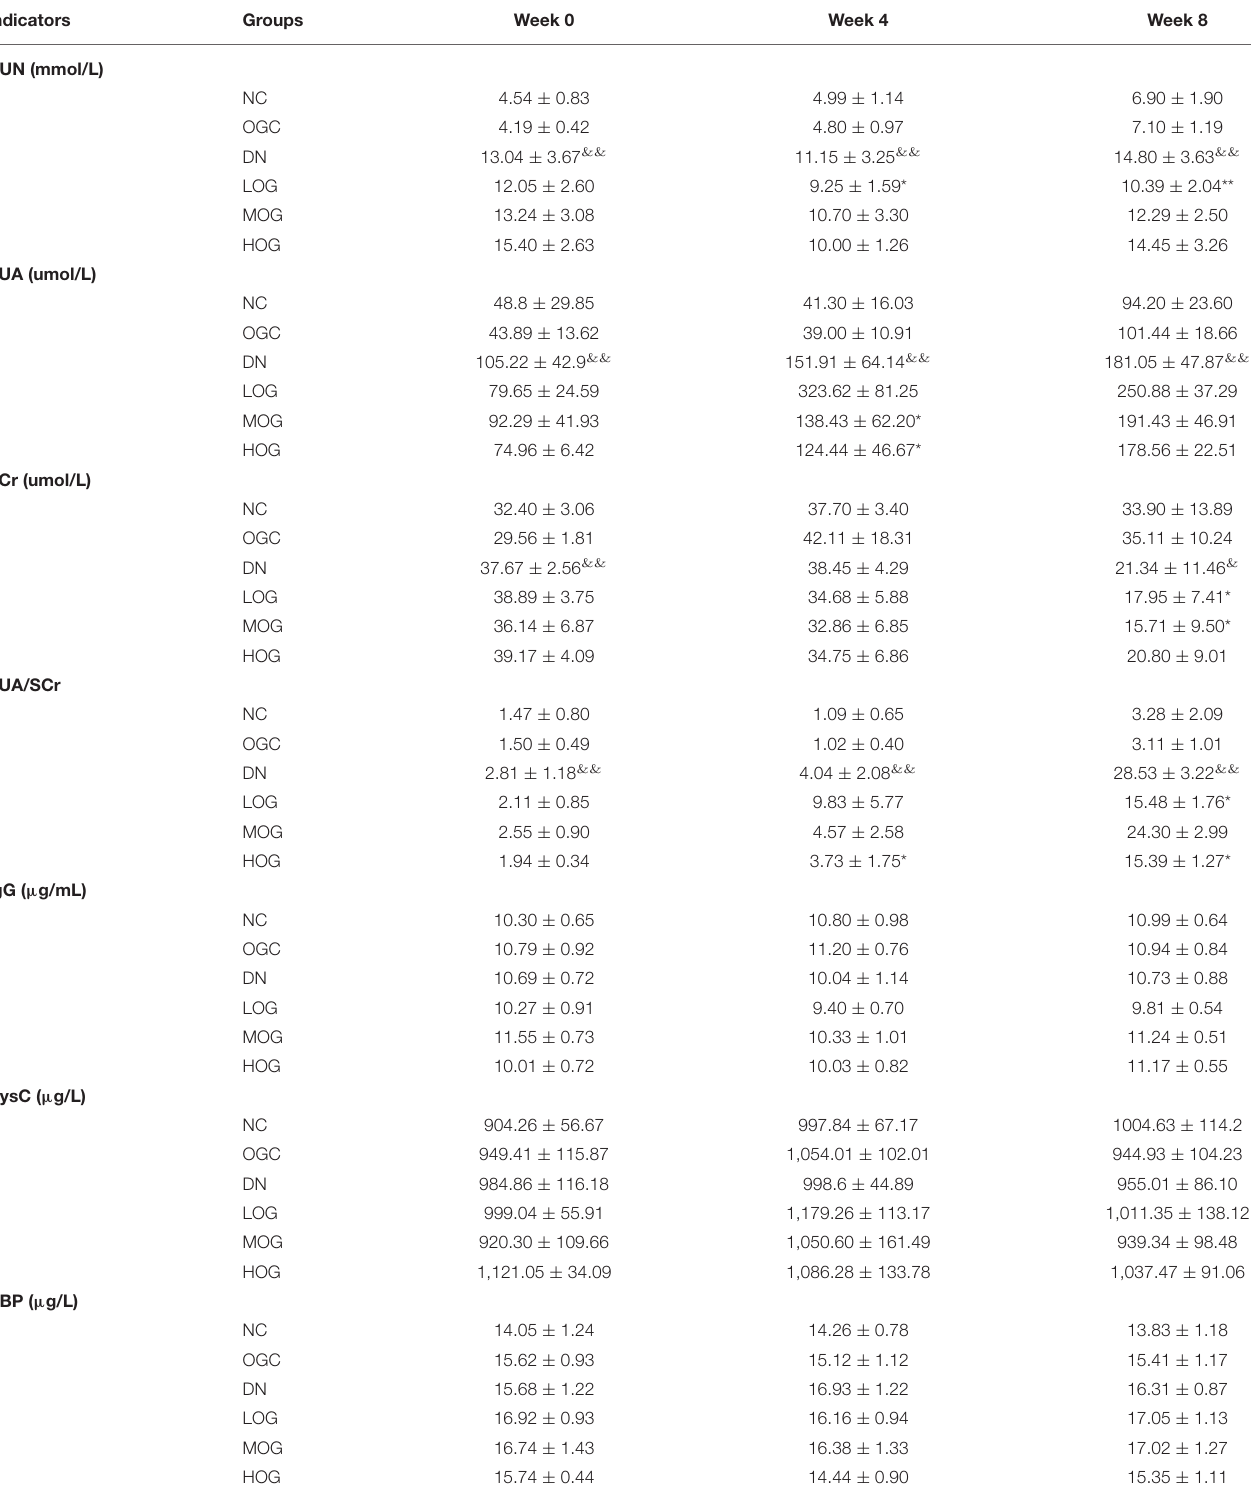
TABLE 1 | Changes in renal function of the rats in each group ( n = 10).